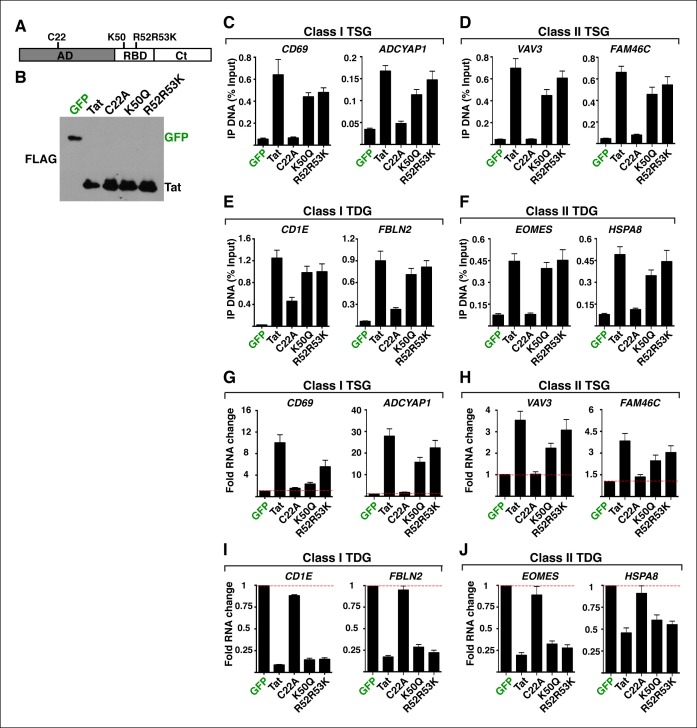
Non-functional Tat mutants have compromised chromatin interaction and modulation of cellular gene expression.(A) Scheme of Tat showing the position of its domains (AD, RBD and Ct) along with the location of the mutated residues. (B) Western blots of Jurkat CD4+ T cell lines expressing GFP, wild-type Tat or non-functional mutants (C22A, K50Q, R52R53K) (D'Orso et al., 2012). Cells from panel (B) were used in ChIP assays to analyze the occupancy of GFP, Tat or the non-functional mutants at class I TSG promoters (C), class II TSG promoters (D), class I TDG promoters (E) and class II TDG promoters (F). Values representing the average of three independent experiments (mean ± SEM; n = 3). Cells from panel (B) were used to isolate total RNA and the expression of class I TSG (G), class II TSG (H), class I TDG (I) and class II TDG (J) was measured by qRT-PCR, normalized to RPL19, and plotted as fold RNA change over the GFP line arbitrarily set at 1 (mean ± SEM; n = 3). AD, activation domain; ChIP-seq, chromatin immunoprecipitation sequencing; Ct, C-terminal domain; GFP, green fluorescent protein; qRT-PCR, quantitative real time polymerase chain reaction; RBD, RNA-binding domain; TDG, Tat downregulated genes; TSG, Tat stimulated genes.